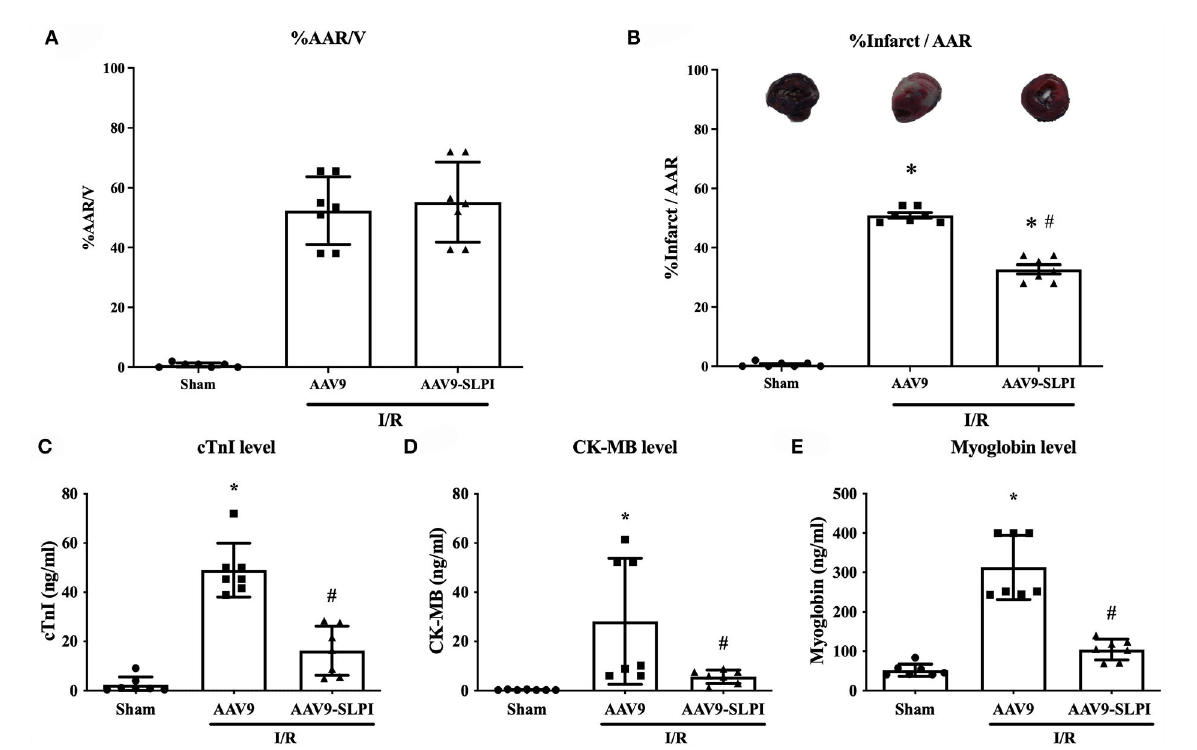
FIGURE3 Determination of infarct size (A) , area at risk (B) , and serum cardiac biomarkers including cTnI (C) , CK-MB (D) , and myoglobin (E) in I/R rats (* p < 0.05 vs. sham) ( # p < 0.05 vs.